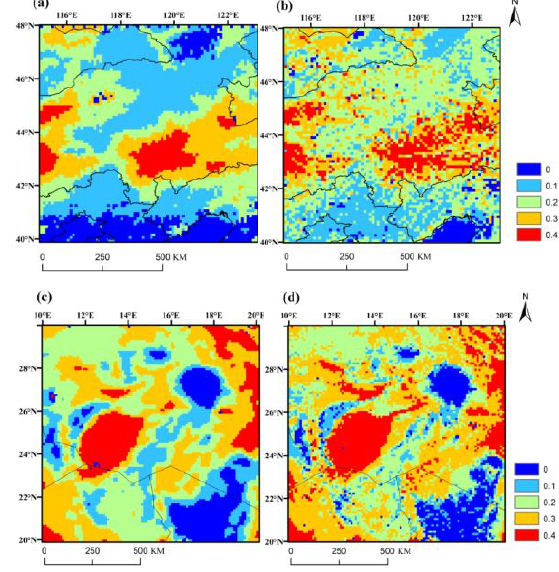
Figure 2. Comparison of black-sky albedo (BSA) in shortwave band , (a) DSCOVR/EPIC albedo in Inner Mongolia, (b) MODIS albedo in Inner Mongolia, (c) DSCOVR/EPIC albedo in Sahara, (d) MODIS albedo in